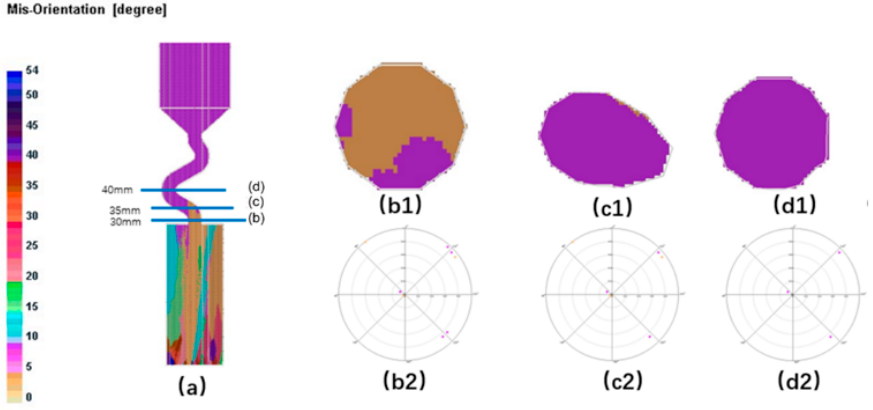
Figure 20. Simulation structure of Z 3 (40°) ( a ); EBSD maps of the grain structure evolution ( b1 , c1 , d1 ) and the EBSD inverse pole figures ( b2 , c2 , d2 ).